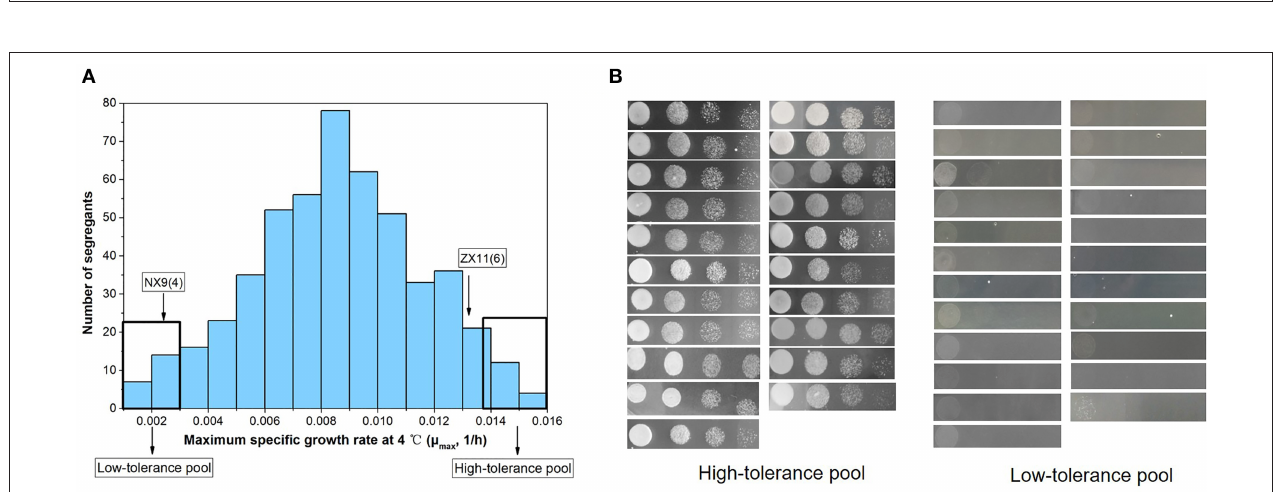
FIGURE 4 | The distribution of the µ max in the F 2 population segregants and two extreme pools were selected for sequencing. (A) The distribution of the µ max in 500 haploid segregants from ZX11(6)/NX9(4). The continuous variation as well as normal frequency distribution was shown. Twenty-one superior segregants with higher µ max ( > 0.0135) were assembled in the “High-tolerance pool” while 23 inferior segregants with lower µ max ( < 0.0030) were selected to assemble the “Low-tolerance pool.” (B) Spot growth on plates at 4 ◦ C of the superior segregants and inferior segregants.